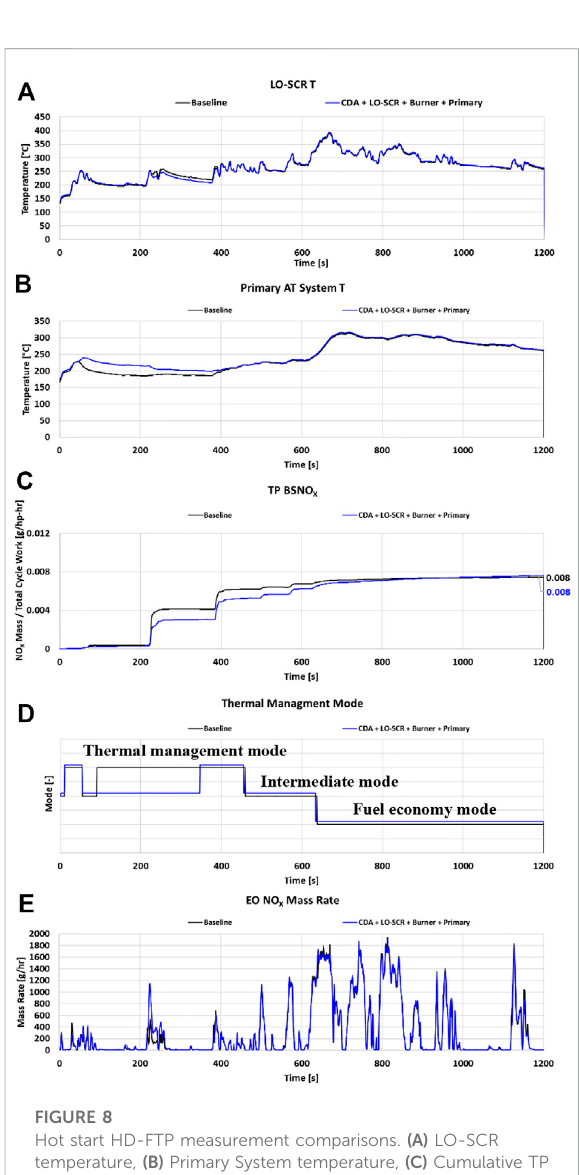
FIGURE 8 Hot start HD-FTP measurement comparisons. (A) LO-SCR temperature, (B) Primary System temperature, (C) Cumulative TP BSNO X , (D) Engine mode comparison, (E) Engine outlet NO X mass